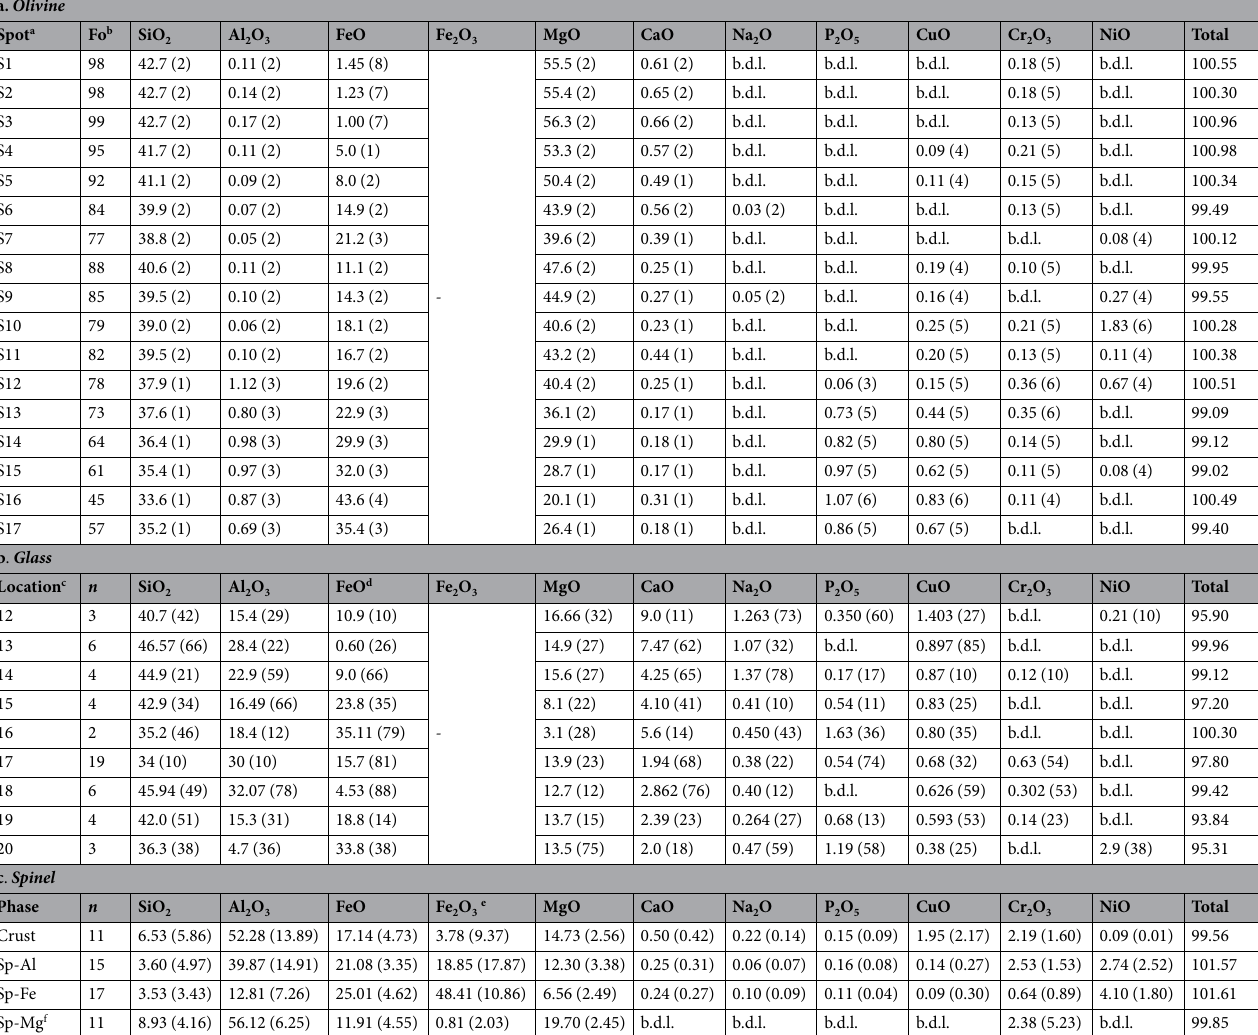
Table 2. Point analyses of olivine (a) and averaged compositions of glass (b) and spinel (c) in 126A by EPMA- WDS. All in compound weight %. n : number of analyses included in average, b.d.l.: below detection limits, 0.02 wt% Ca, 0.03% Na, 0.02% P, 0.08% Cu, 0.06% Cr, 0.06% Ni; SEM-EDS detection limit ~0.1 wt%.